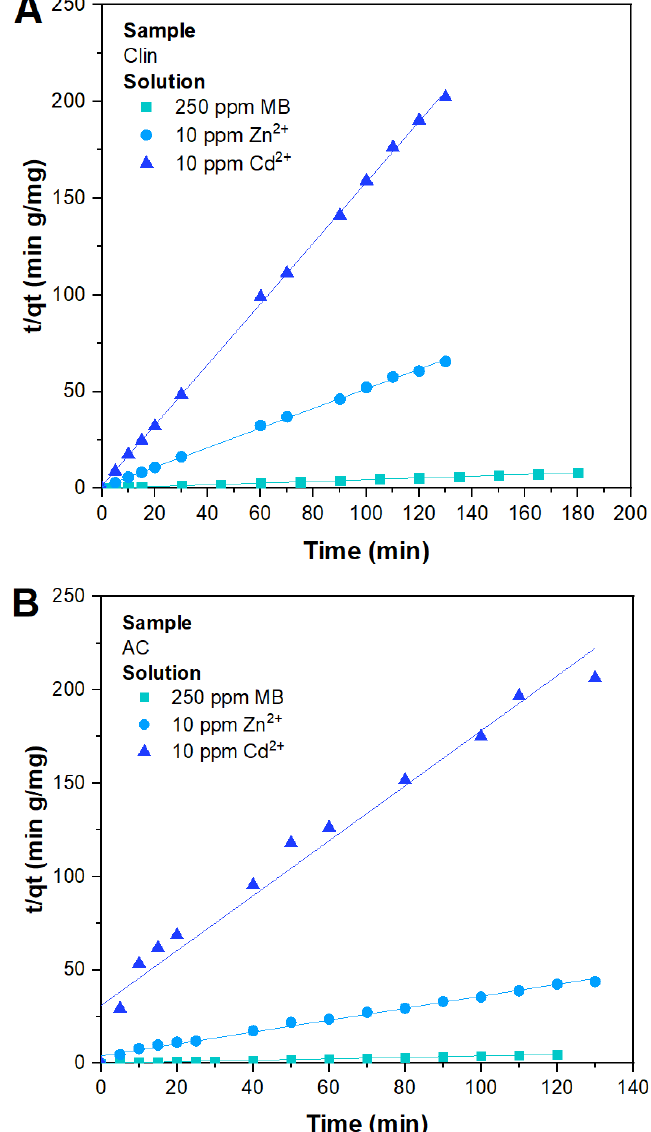
Figure 8. Experimental data of a system with 250 ppm MB, 10 ppm Zn 2+ , and 10 ppm Cd 2+ fitted with a PSO kinetic model by using Clin ( A ) and AC ( B ) as adsorbents.